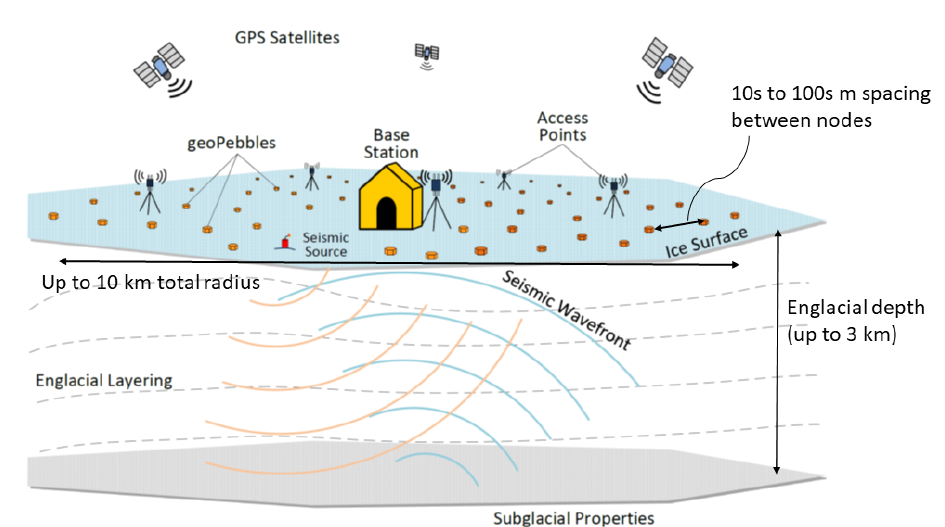
Figure 1. Virtual experiment with geoPebble nodes scattered on the surface of an ice sheet. Over 100 wireless geoPebble nodes can be distributed on the surface. Each node contains an L1 (survey quality) GPS device, which eliminates the need to survey node locations and a seismic data-logger for simultaneous seismic measurements. The entire geoPebble mesh can be reconfigured easily and quickly to conduct a variety of seismic